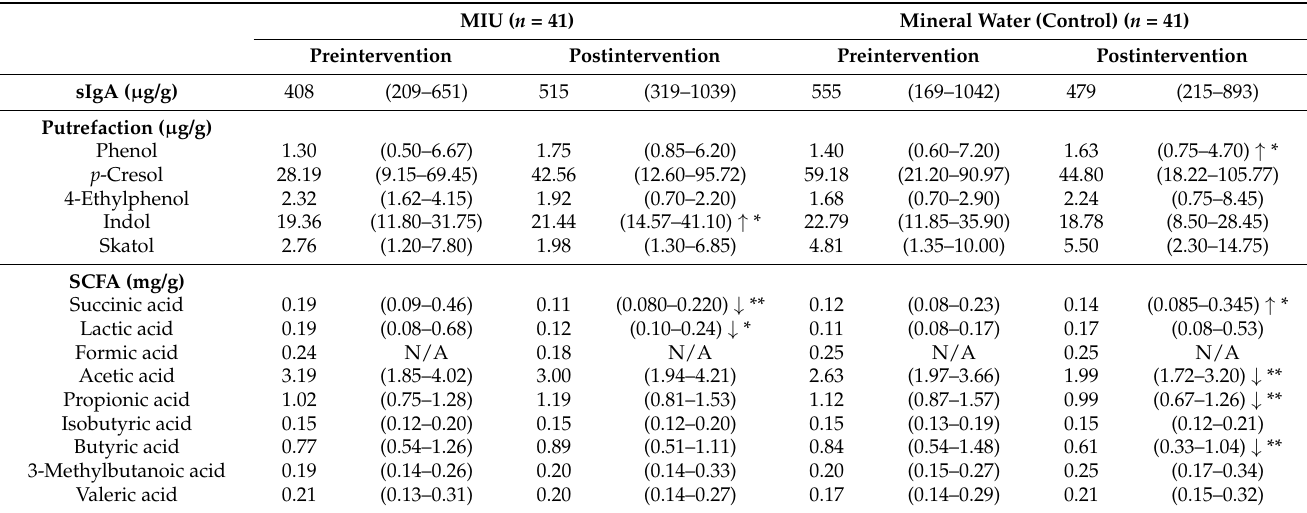
Table 2. The values of fecal biomarkers in the 2 intervention